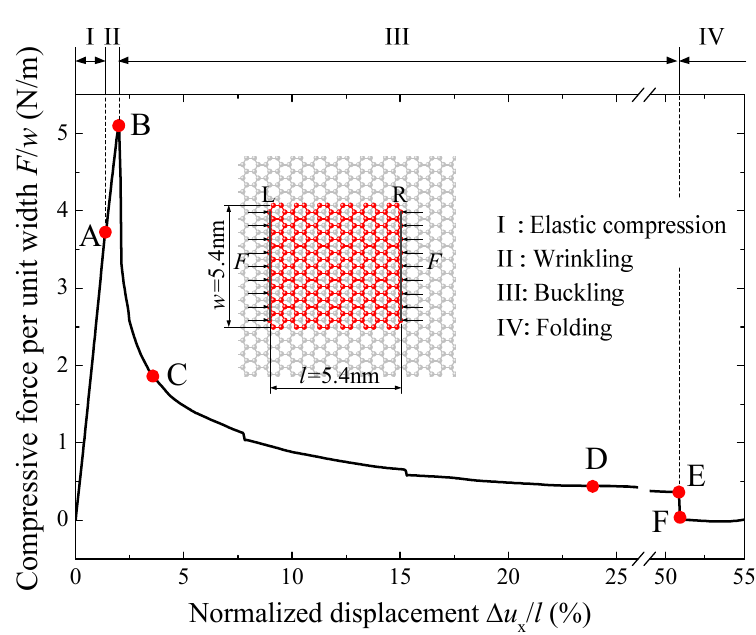
Figure 2. The compressive stress versus normalized displacement of the monolayer graphene sheet supported by a graphene substrate.